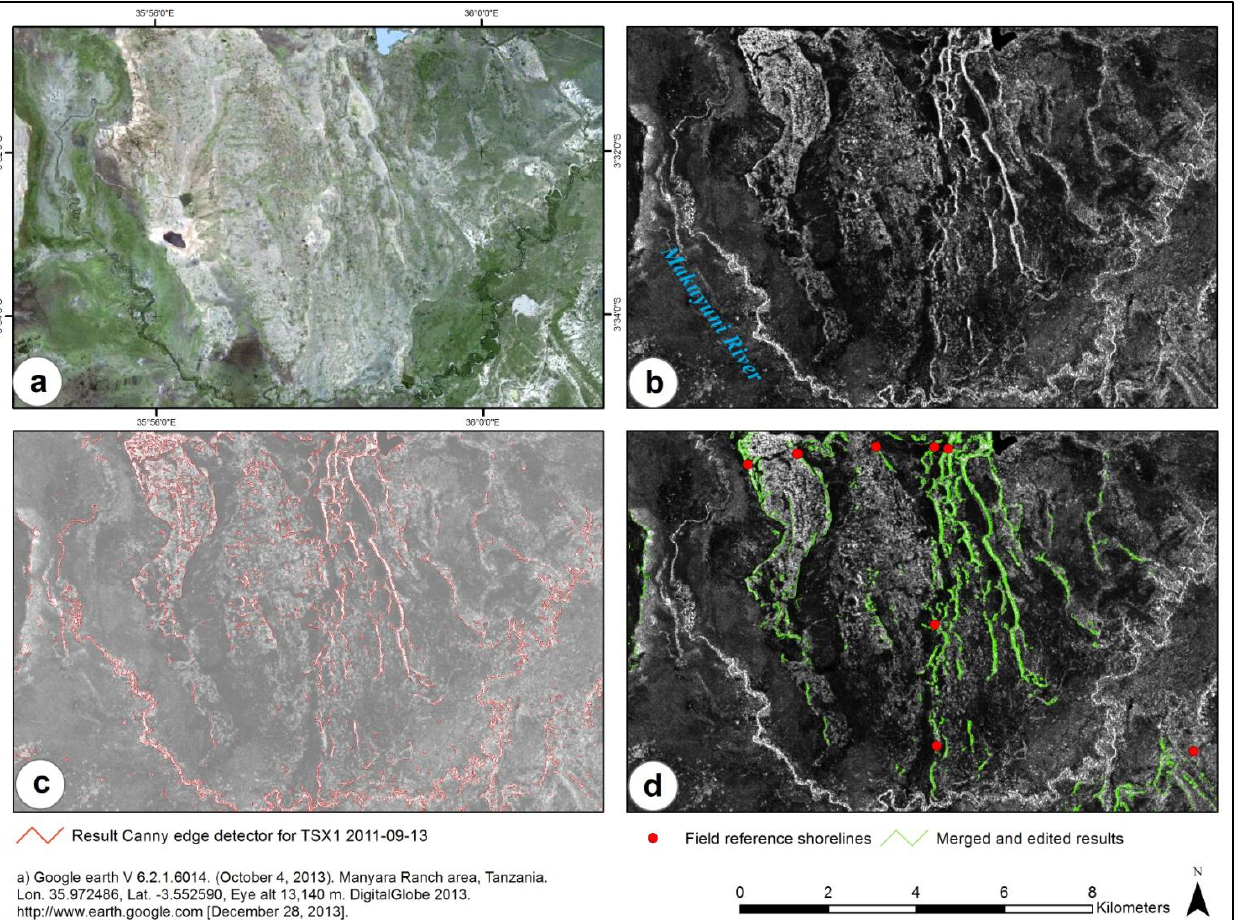
Figure 3. Example of the workflow for a small area; ( a ) Optical reference image; ( b ) TSX1 image (13 September 2011); ( c ) Result of the Canny edge detector (background: transparent TSX1 image); ( d ) Results of shoreline extraction after